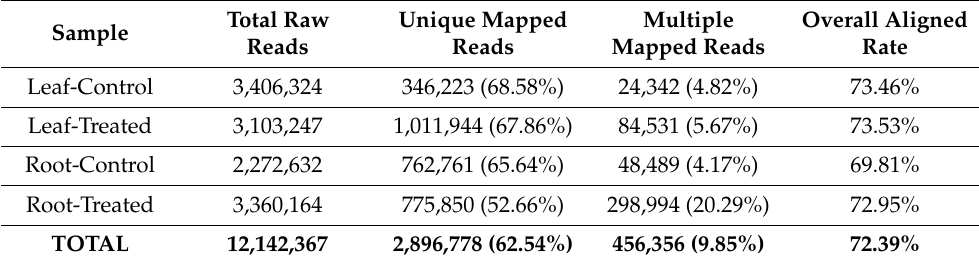
Table 1. Summary statistics of read alignment over the reference pearl millet genome.